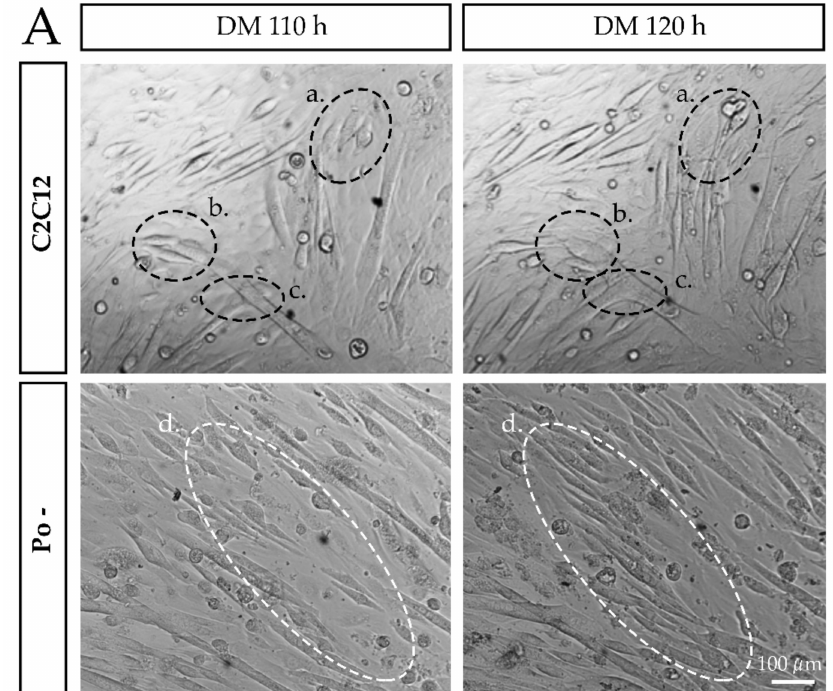
Figure 2. Live-cell monitoring of fusion dynamics in WT C2C12 and Po – cells at 110 h and 120 h of myogenic di ff erentiation. The C2C12 myoblasts, in the process of di ff erentiation, align and fuse together to form nascent myotubes, in the primary fusion step ( a ). Then, some of the surrounding reserve cells fuse with the nascent myotubes participating in their elongation, in the secondary fusion step ( b ). Primary myotubes also fuse together in the secondary fusion process ( c ). In the case of Po – myoblasts, they align and rapidly fuse into elongated myotubes, but only include a small number of nuclei ( d ). Thus, the surrounding reserve cells will not fuse with these atypical myotubes and lengthen